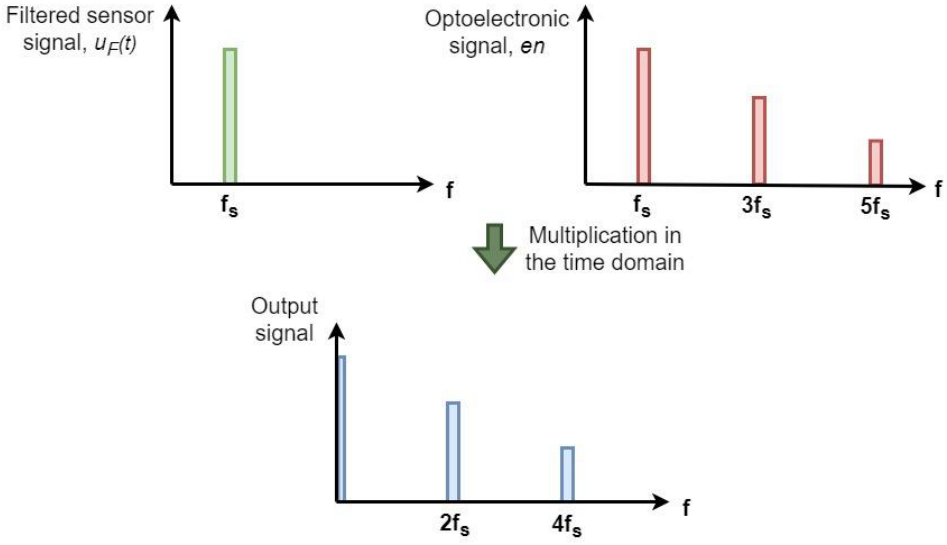
Figure 3. Multiplication in the time domain — spectrum analysis.